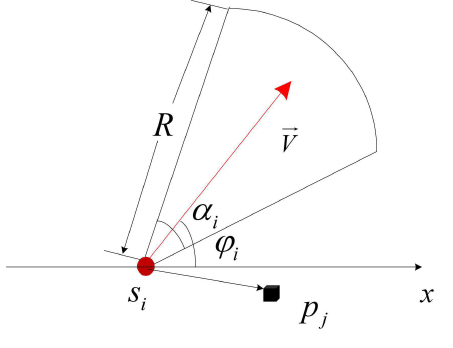
Figure 3. Sensing